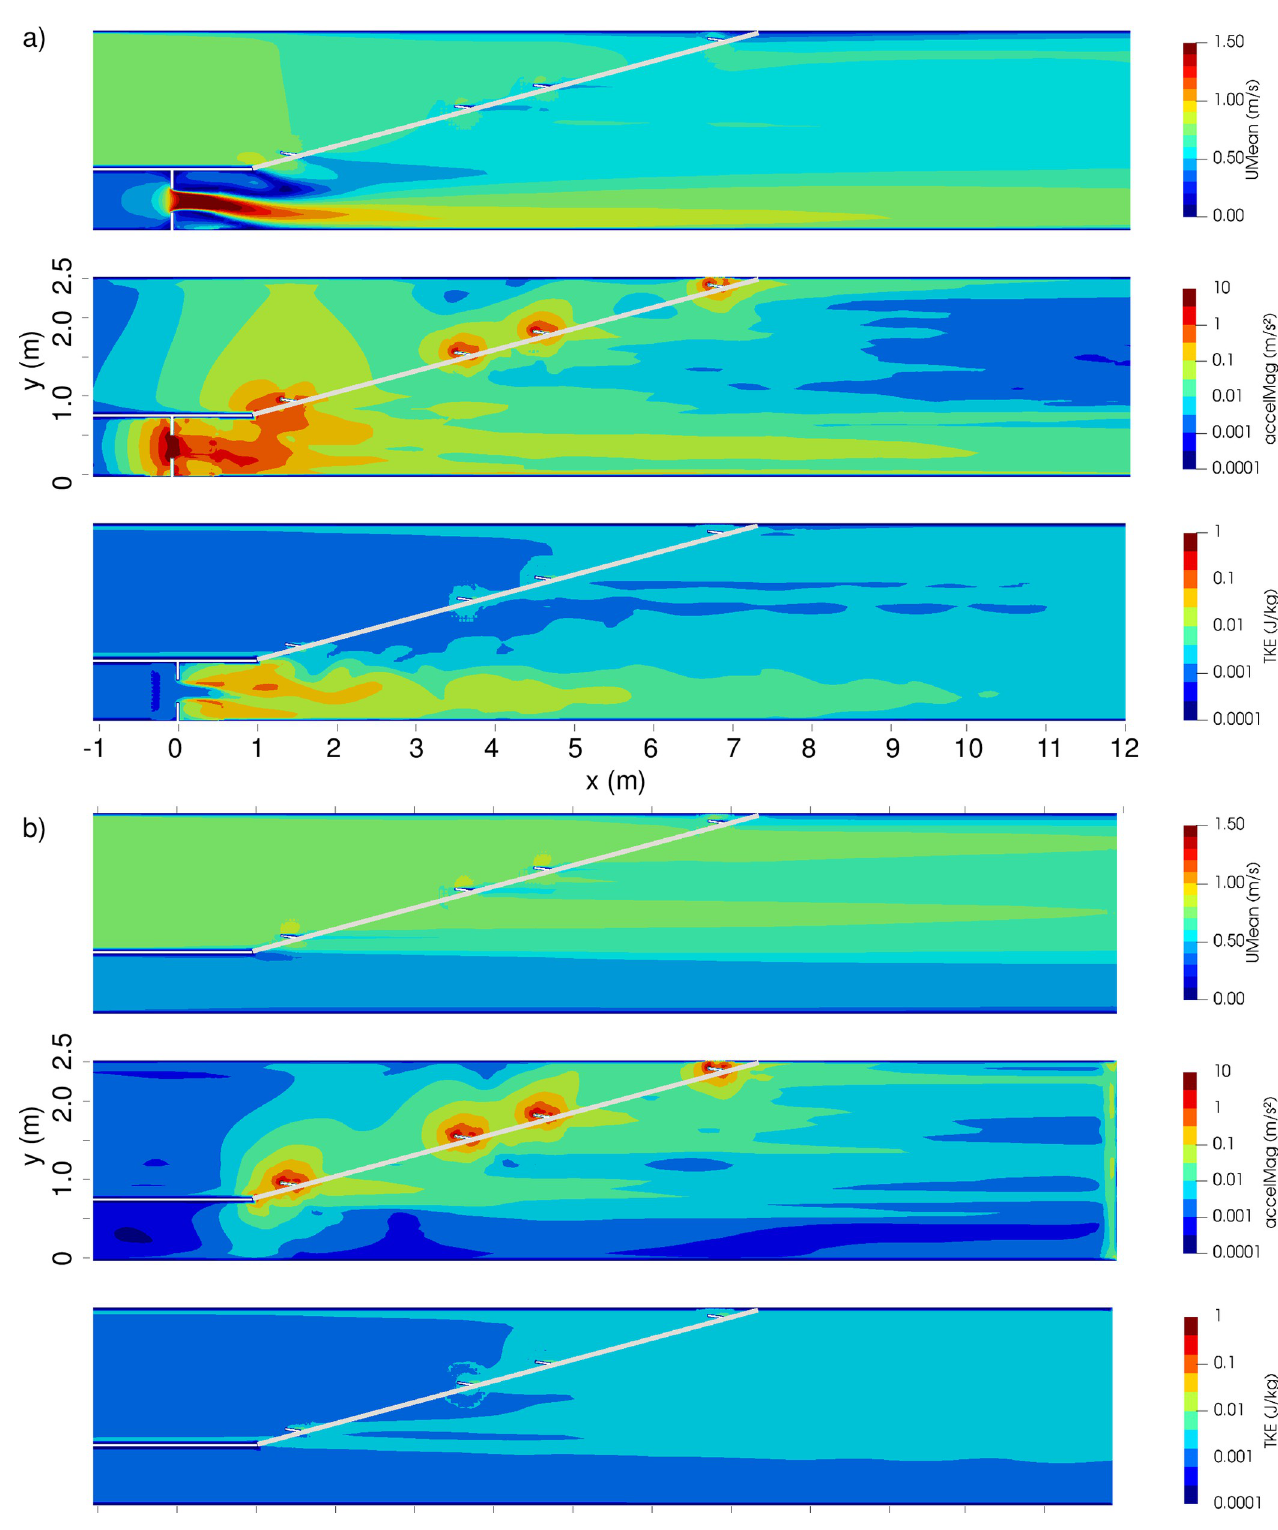
Fig 4. Horizontal flow field slices of setup 1 (a) and setup 2 (b) illustrate the effect of the slot and jet and its removal. Flow from left to right. Plane at z = 0.07 m above bottom where trout preferred to stay. Water depth = 0.60 m. Sub-panels in (a) and (b) show velocity magnitude U m (top panels), acceleration magnitude (middle panels), and TKE (bottom panels). Note logarithmic scale for acceleration and TKE.